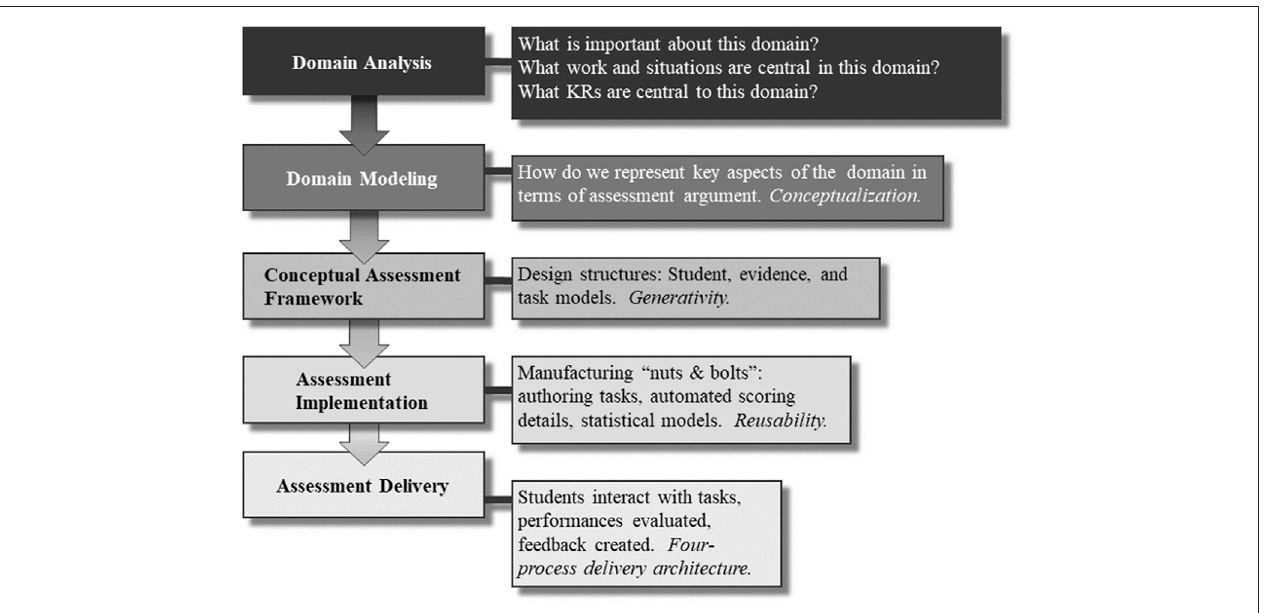
FIGURE 1 | Layers of ECD from Mislevy and Riconscente,